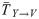
Transfer entropy TY→V for the feedback model governed by Eq (6) as a function of the noise intensity σ2 for k = 1 (blue circles), k = 3 (green circles) and k = 5 (red circles).The parameter l present in the definition of Eq (1) is fixed to 1. The lower red (resp. upper blue) solid line represents the value of TY→V (resp. T¯Y→V) obtained by multiplying the theoretical rate TY→V (resp. T¯Y→V) given by Eq (21) (resp. Eq (23) by the sampling time τ = 10−3. The parameters of the model are T = 5, γ = m = 1, τr = 0.1, and a = 8.